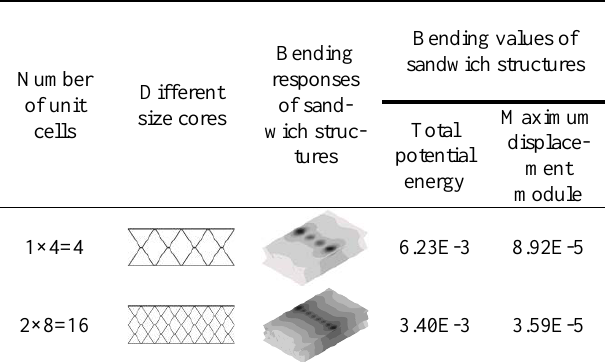
Table 6. Bending deflections of sandwich structures wi different size X-cores